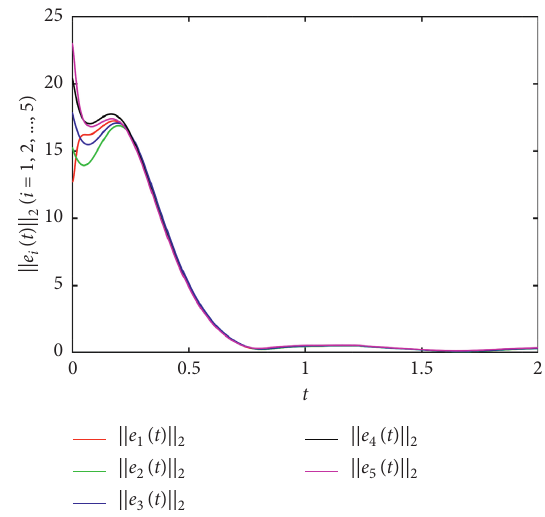
Figure 2: The changes of ‖ e under the control strategy designed by Theorem